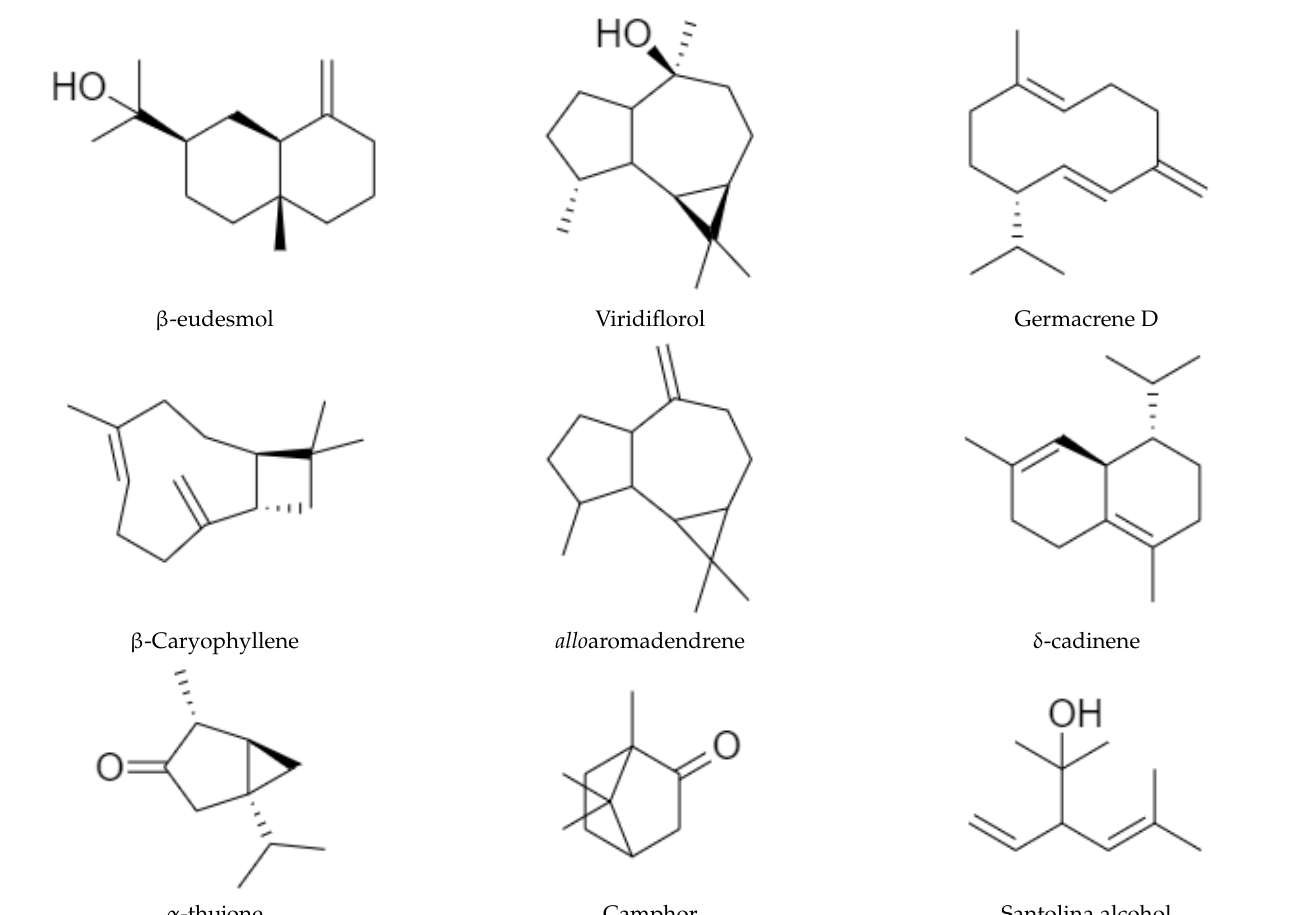
Table 3. The structure of the most abundant terpenoids of A. ligustica samples. flower sample 1 .